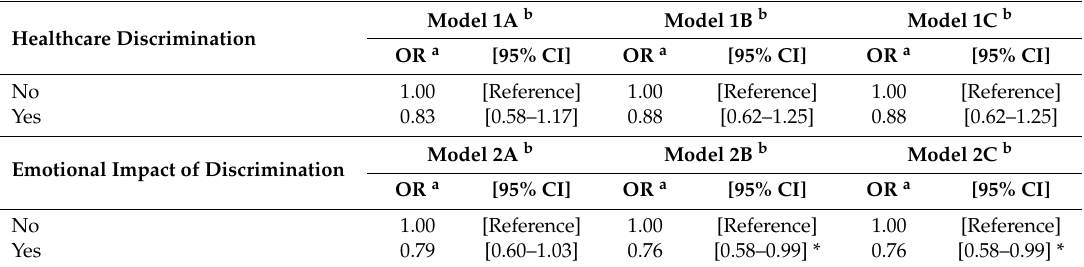
Table 3. Regression models for the association between indicators of racial discrimination and use of dental services in the past year among American adults ( n =